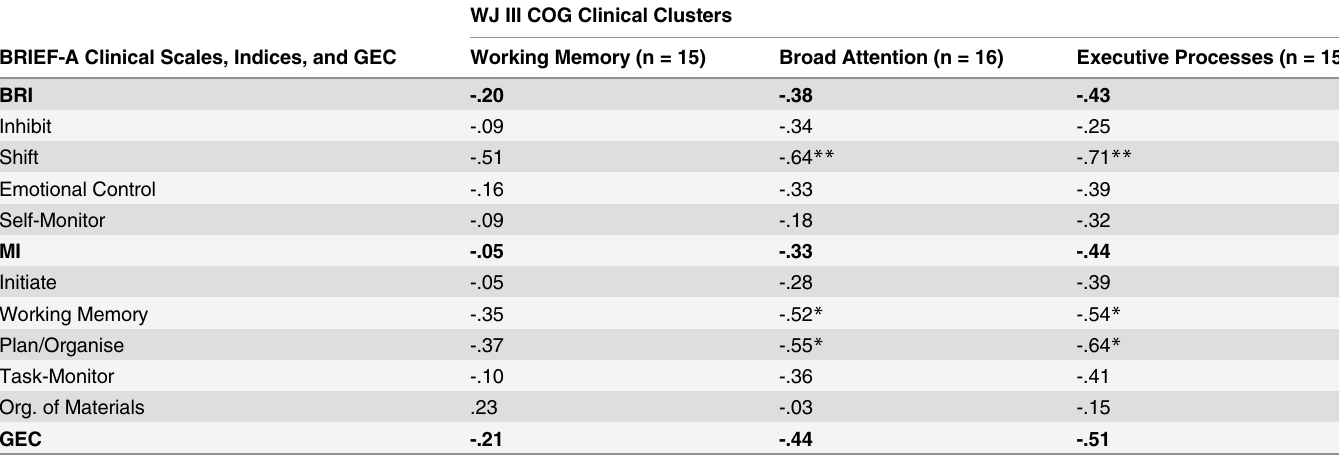
Table 4. Correlations Between the WJ III COG and the BRIEF-A (T